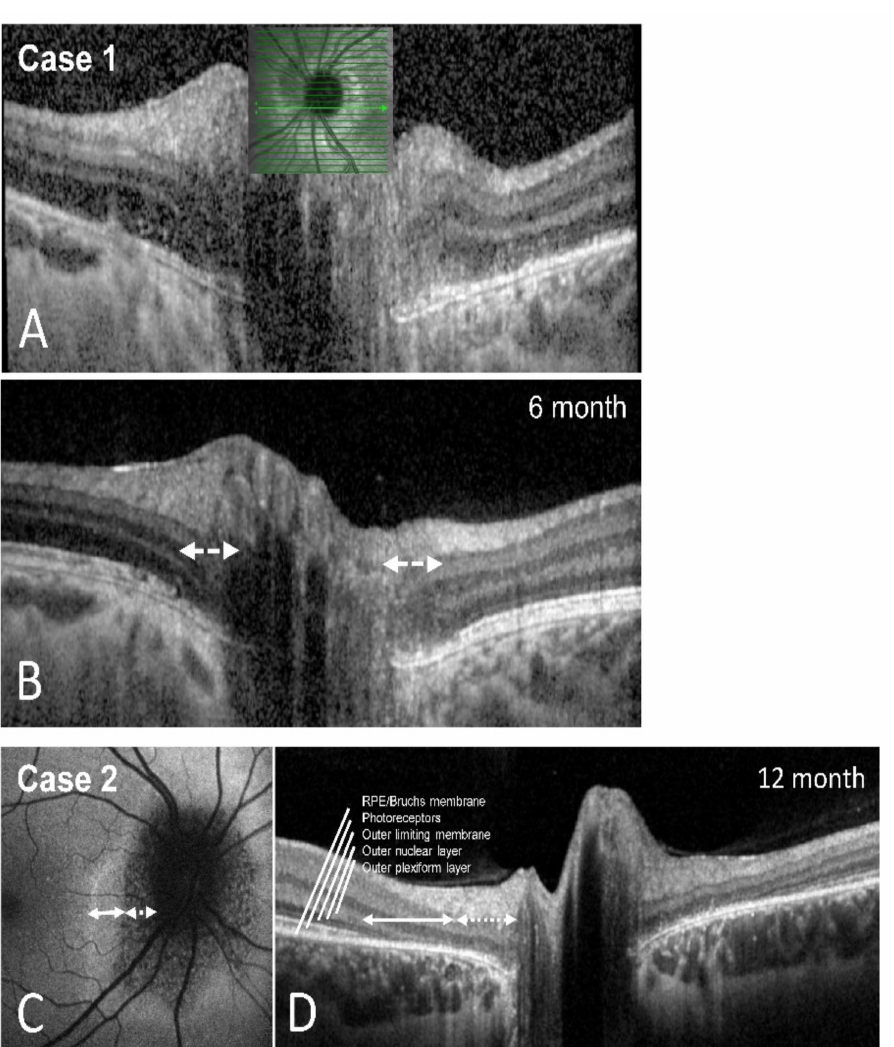
Figure 3. Restoration of outer retinal layer anatomy. SD-OCT scans (Heidelberg Engineering, Heidelberg, Germany). ( A , B ): Horizontal OCT cross sections of case 1 at first presentation ( A ) and after six months ( B ), showing restoration of the outer retinal layers in the peripapillary area except of the most proximal disc part, marked with arrows ( B ). ( C , D ): Autofluorescence ( C ) and OCT ( D ) of case 2 after 12 months. A hyperfluorescent and hypofluorescent area was apparent over time in the affected zone. Degeneration of the outer plexiform and outer nuclear layers (dotted arrow) represent the difference between both areas, resulting in